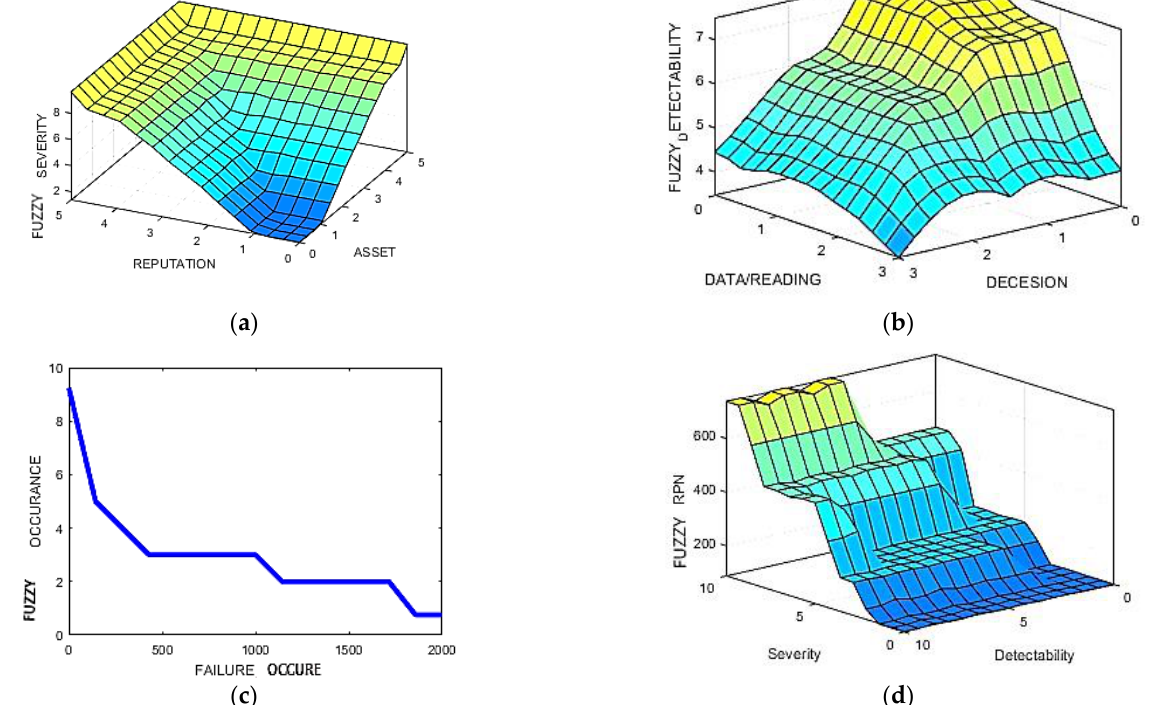
Figure 6. The sample surface viewer or surface map for 4 fuzzy logic systems: ( a ) Fuzzy severity plot; ( b ) Fuzzy detectability plot; ( c ) Fuzzy occurrence plot; ( d ) Fuzzy risk quantification value RPN.